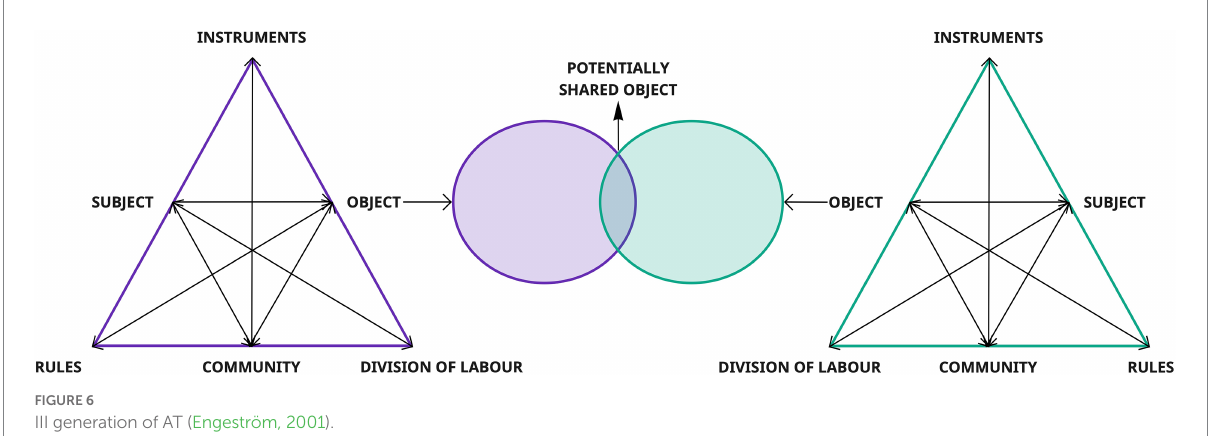
FIGURE 6 III generation of AT (Engeström,